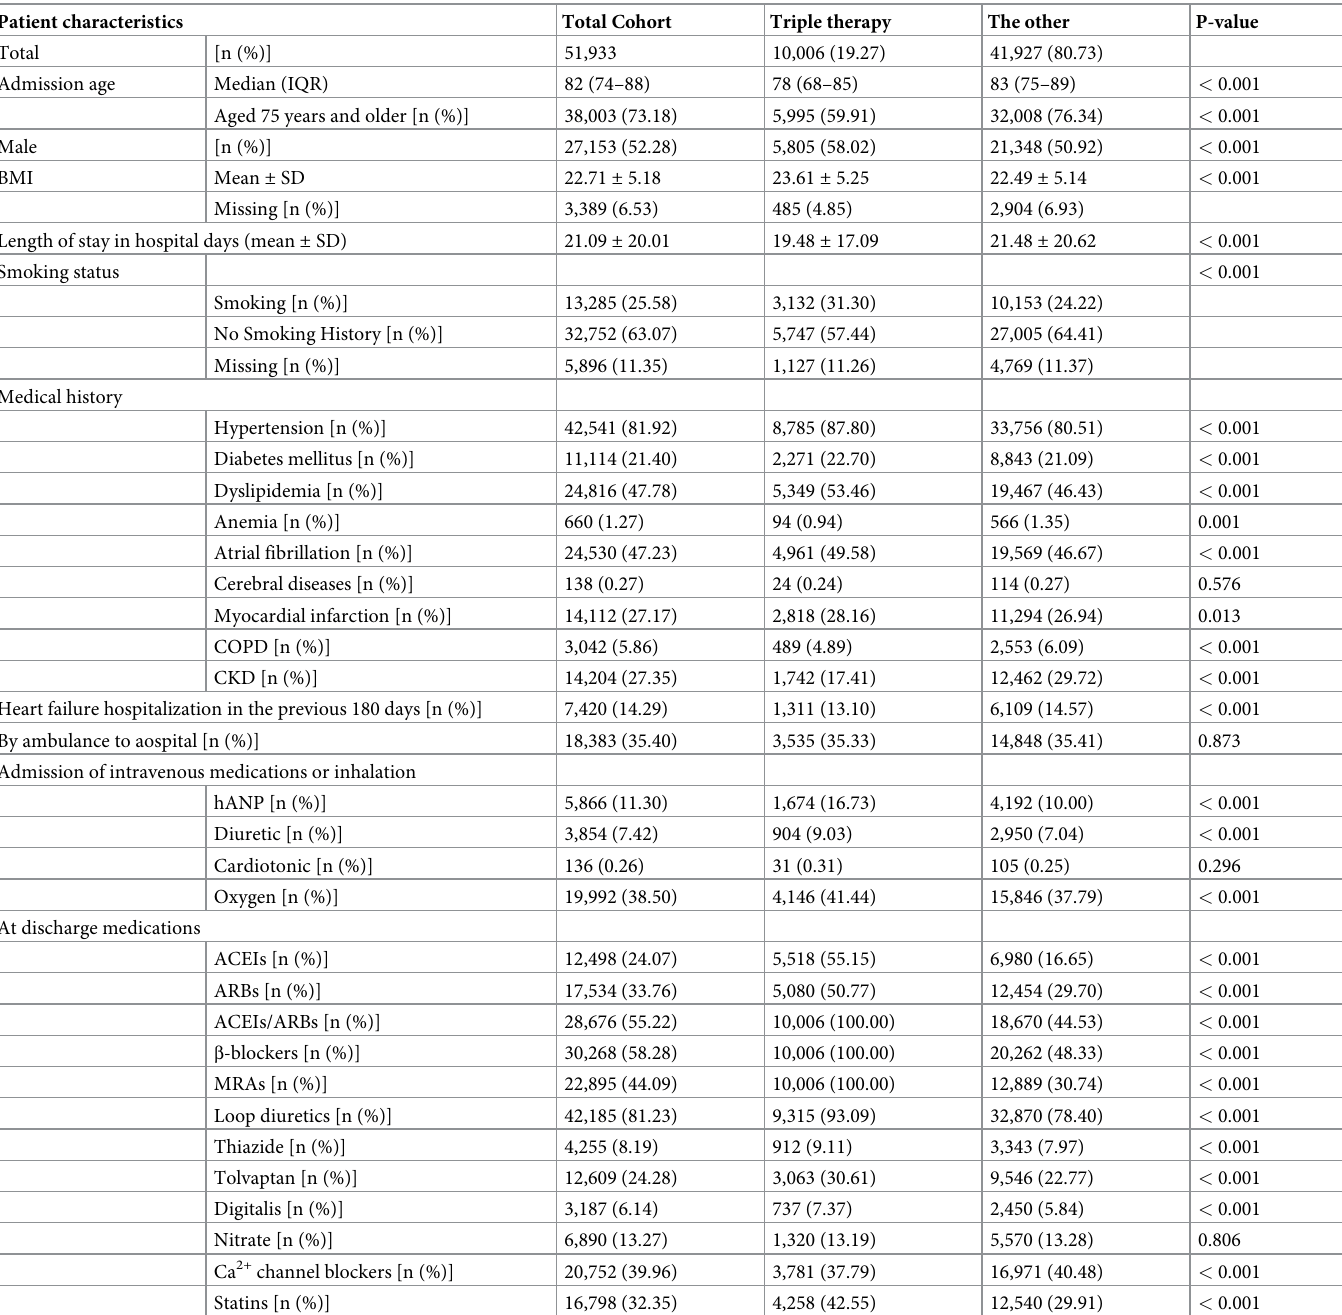
Table 1. Characteristics of patients receiving triple